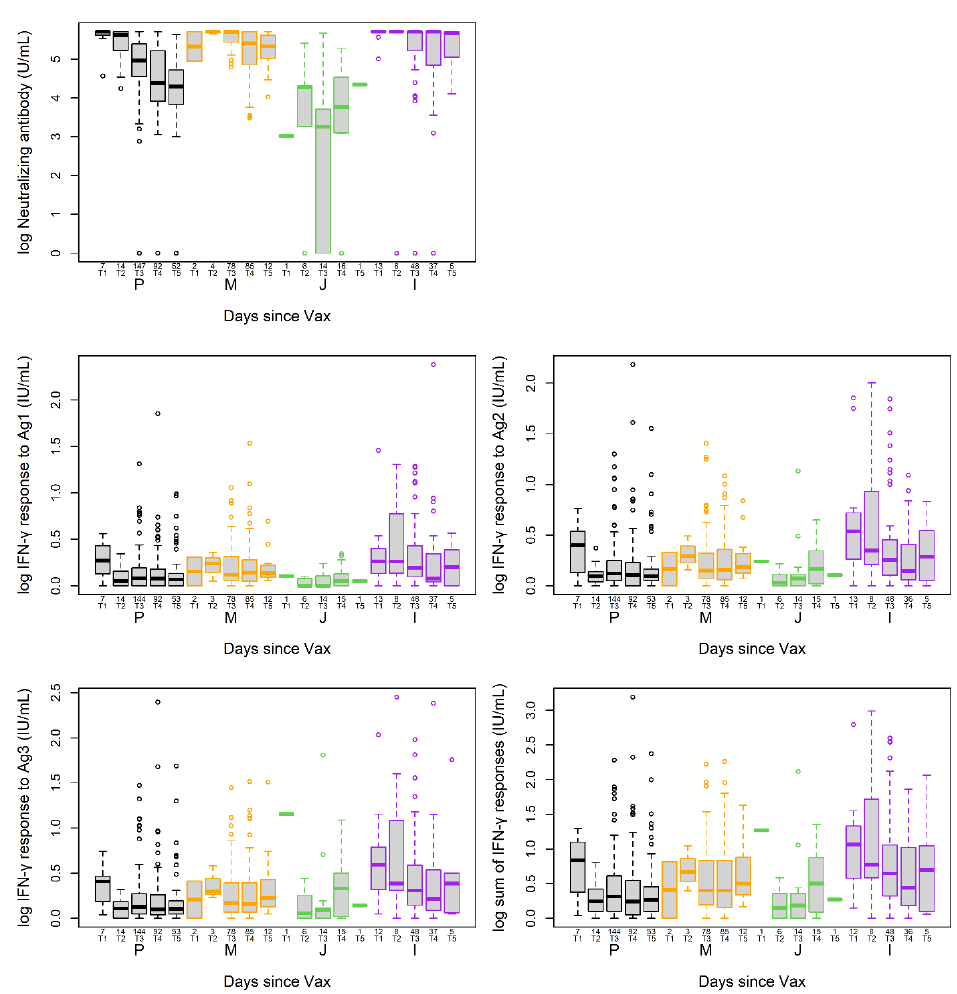
Figure 2. Distributions for T cell and NAb responses in participants receiving different SARS-CoV-2 vaccines. Each box shows the IQR with the median as the interior bar; the outer bars stretch out to the minimum and maximum, with the exception that points outside the fence are shown as individual circles. P: Pfizer; M: Moderna; J: Johnson & Johnson; I: previous infection or positive anti-N; T1: 0 – 2 months; T2: 2 – 4 months; T3: 4 – 6 months; T4: 6 – 8 months; T5: 8 – 10.5 months. Numbers indicated the time period indicators (e.g., T1–T5) are the number of participants for that